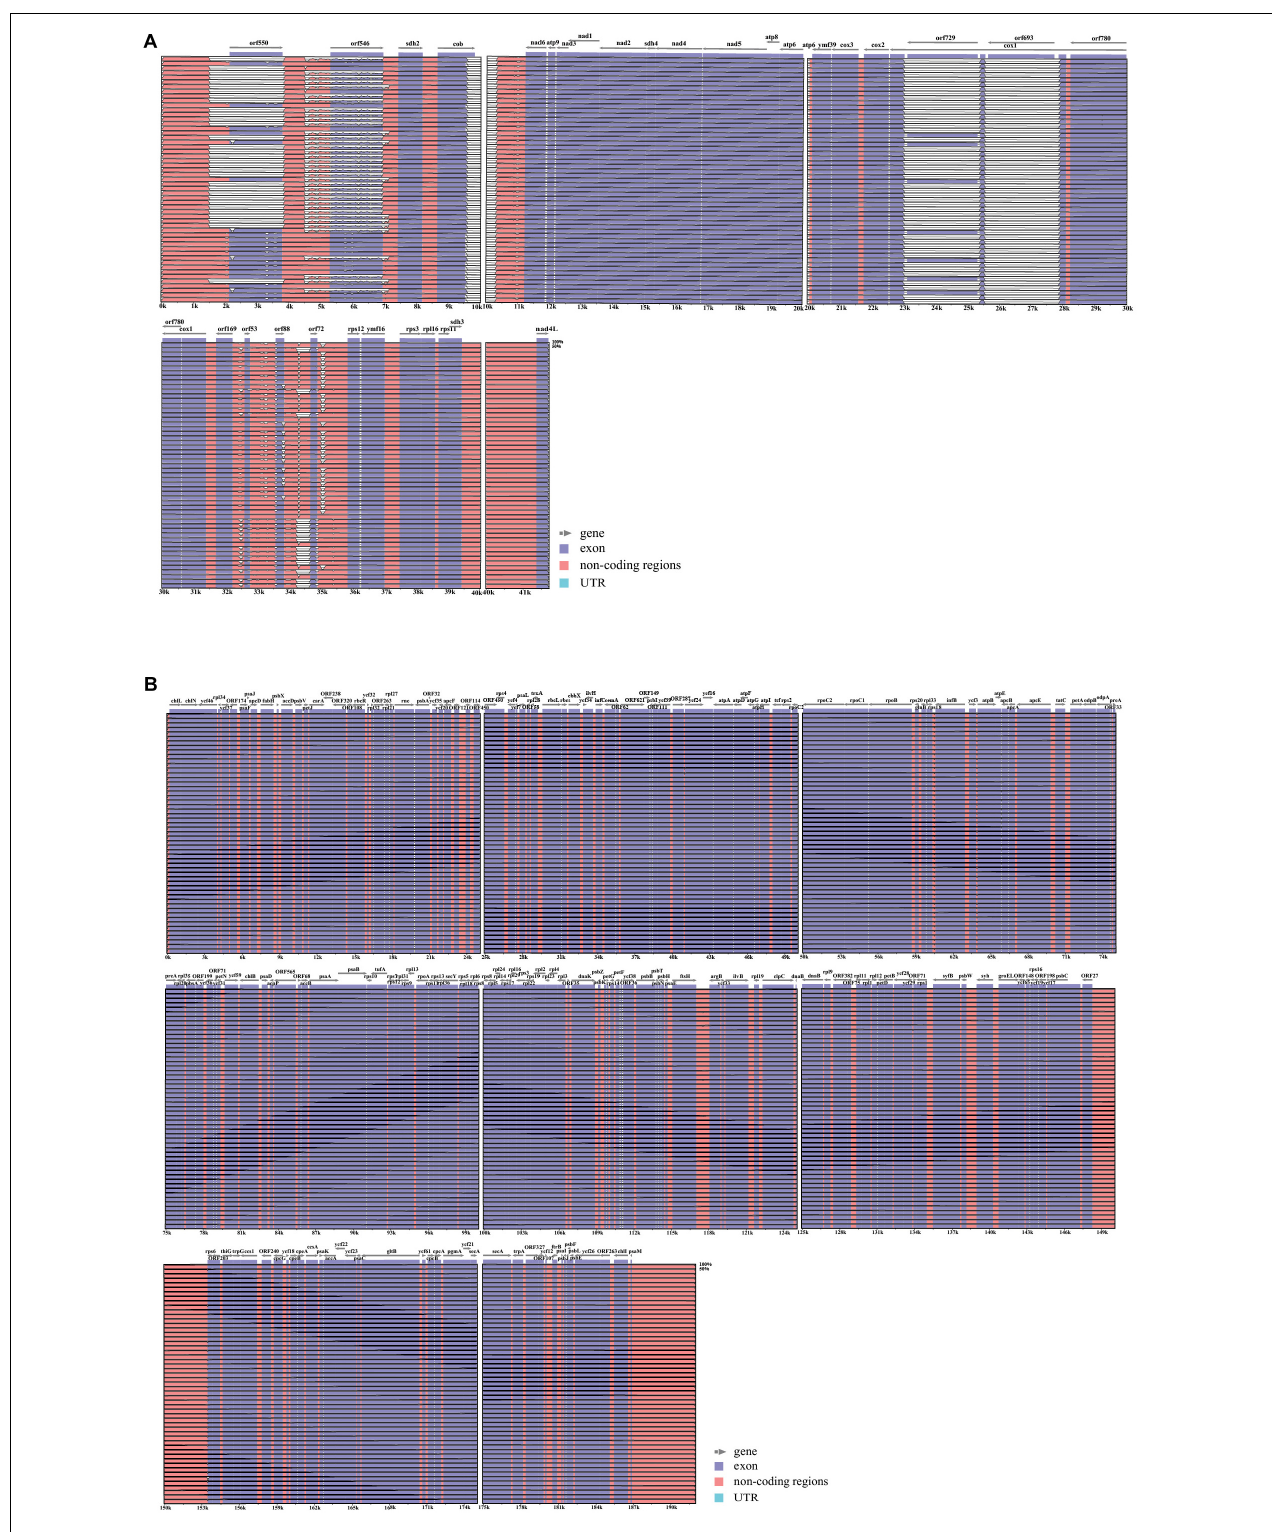
FIGURE 2 | Visualization of the alignment of the organellar genome sequences. (A) VISTA-based identity plots showing sequence identity among the 53 sequenced mitochondrial genomes; (B) VISTA-based identity plots showing sequence identity among the 53 sequenced plastid genomes with Pyropia yezoensis RZ-58 as a reference. Each genome region from the lower boundary to upper boundary indicates the sequence identity ranging from 50% to 100%.